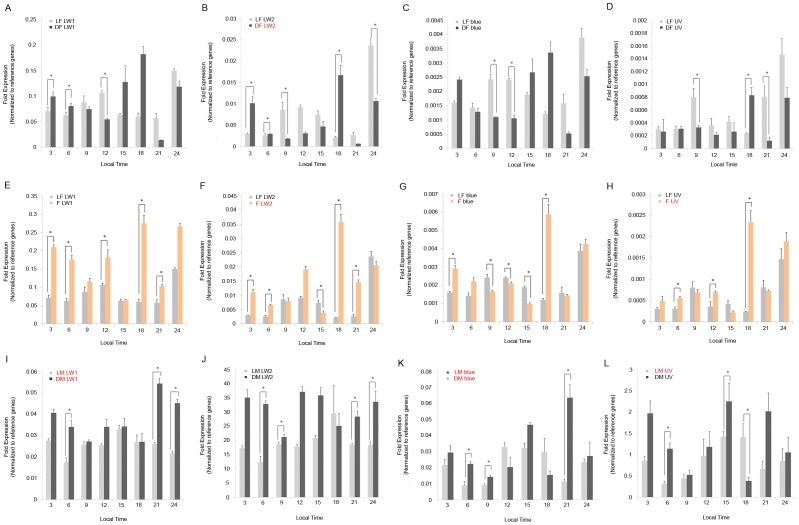
Relative expressions of the four opsin genes in female and male Ceratosolen solmsi.Abundance of mRNA in opsin genes relative to reference genes at each time point are represented by bars. Samples from inside of light (L) and dark (D) treated fig fruits are denoted by grey and black bars, respectively, and emerged females (F) exposed to light were denoted by orange bars. Significant differences in opsin gene expressions caused by light treatment at each time point are marked with an asterisk. The genes that show significant rhythmicity in a 24 hour cycle for each treatment are shown in red. Error bars (+ S.E.M for three biological replicates) are shown for all samples. LF: fig-female light; DF: fig-female dark; F: emerged female light; LM: fig-male light; DM: fig-male dark.